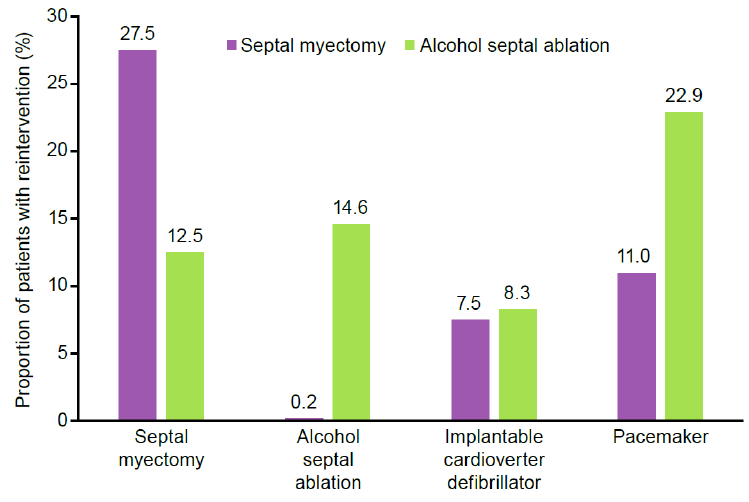
Figure 6. Reintervention rates following initial septal reduction therapy.